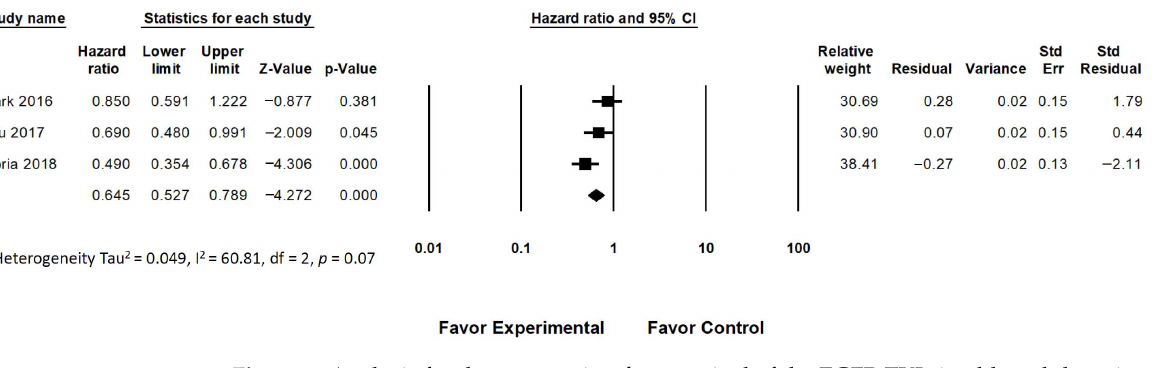
Figure 3. Analysis for the progression-free survival of the EGFR TKIs in older adult patients (The effect size for each study is represented by a square, with the location of the square representing both the direction and magnitude of the effect. The summary effect is represented by a diamond. The location of the diamond represents the effect size while its width reflects the precision of the estimate.) [12,14,16].